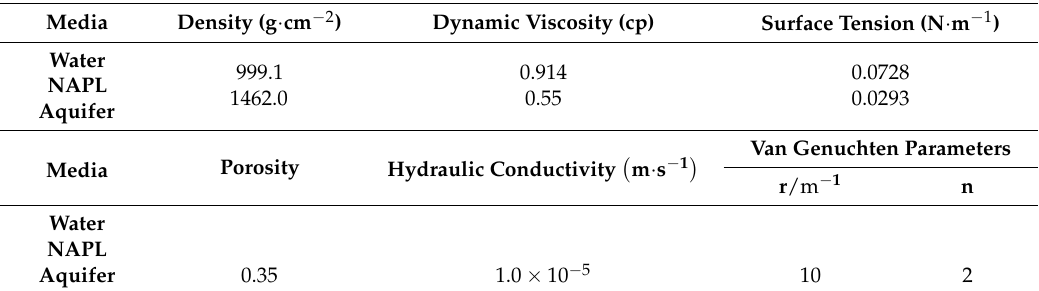
Table 2. Physical properties of media (24 ◦